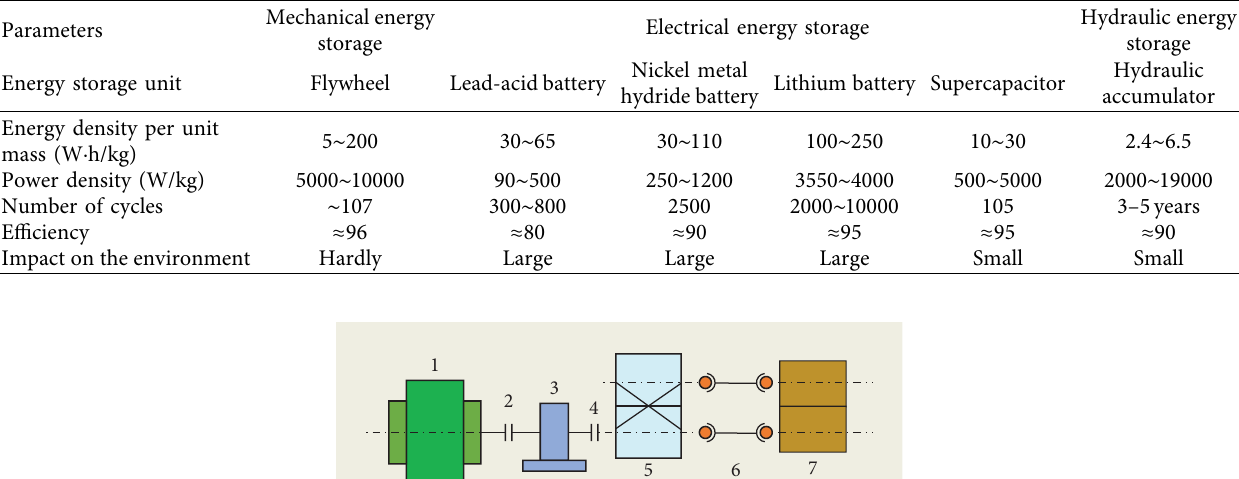
Table 1: Performance parameters of diferent energy storage elements